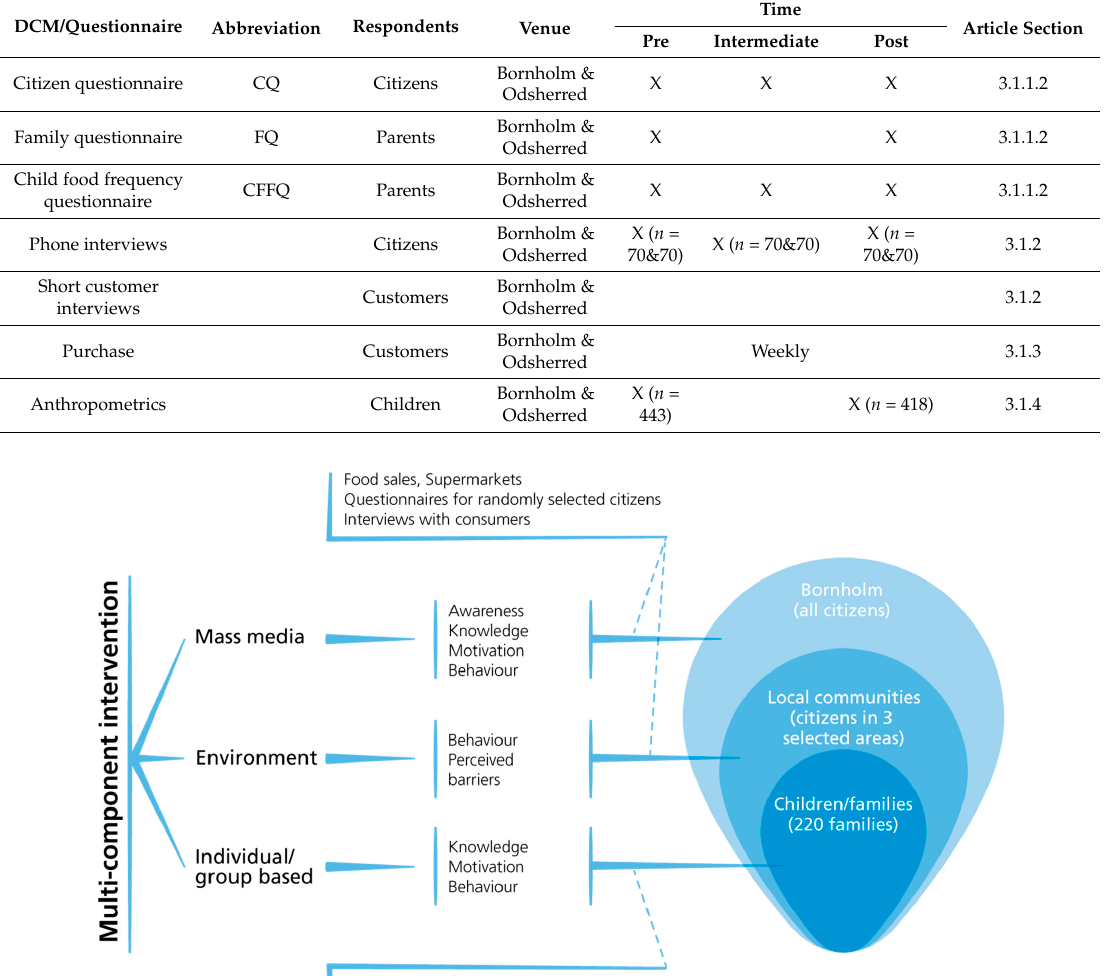
Table 1. Overview of formative and summative data collecting methods.